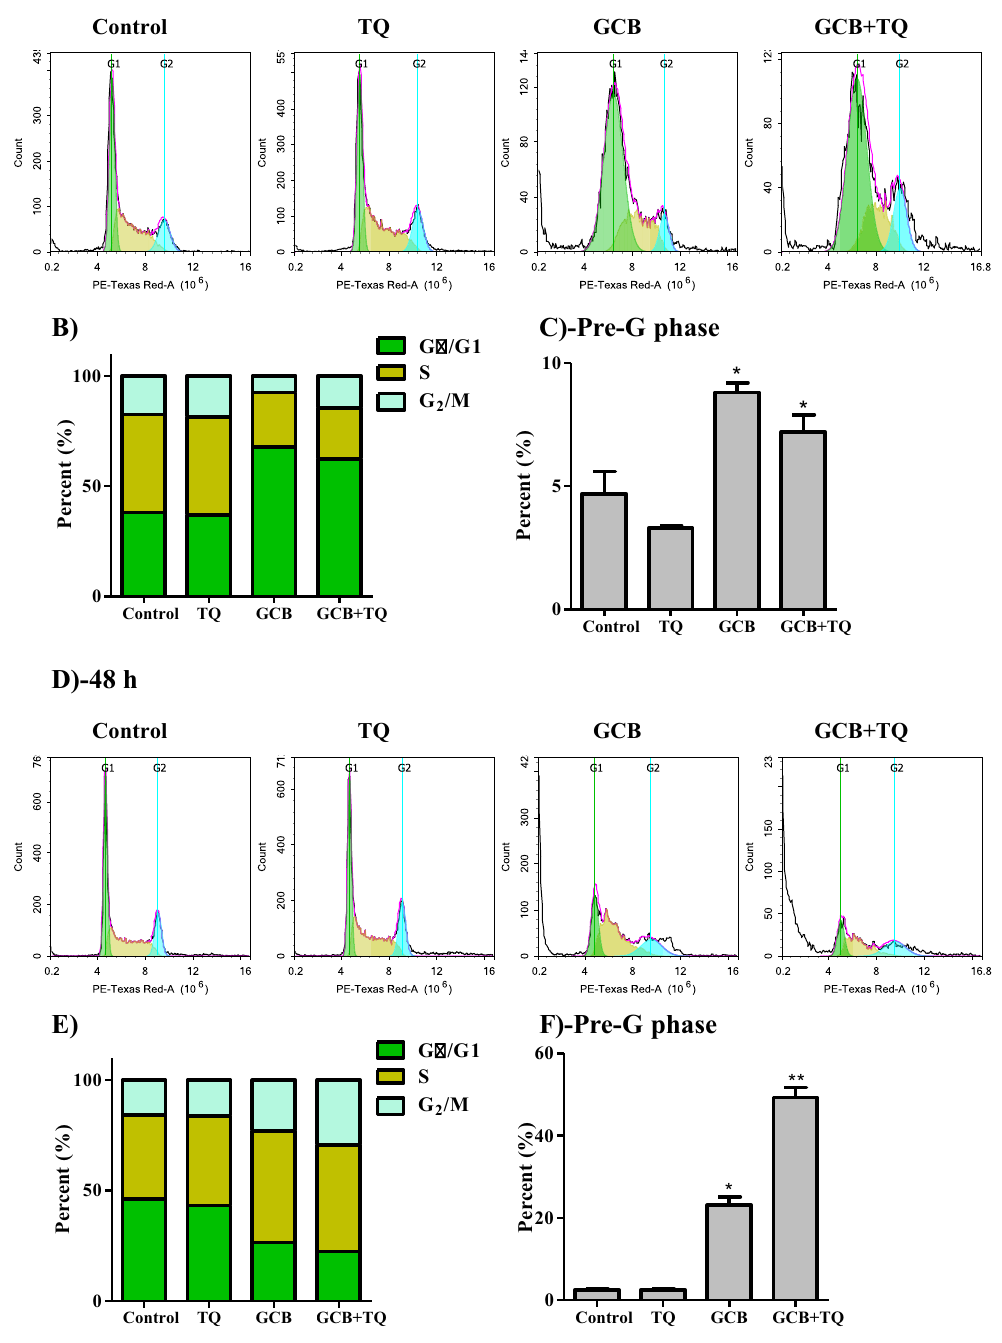
Figure 2. Effect of GCB, TQ and their combination on the cell cycle distribution of MCF-7 cells. Cells were exposed to GCB, TQ or their combination for 24 h ( A – C ) or 48 h ( D – F ). Cell cycle distribution was determined using DNA cytometry analysis and different cell phases were plotted ( B , E ) as percentage of total events. Sub-G cell population was plotted as percent of total events ( C , F ). Data is presented as mean ± SD; n = 3. * Significantly different from control group. ** Significantly different from GCB